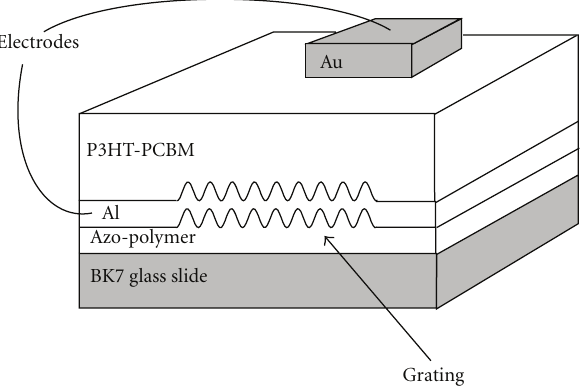
Figure 1: AFM picture of a surface relief di ff raction grating with Λ = 250nm.